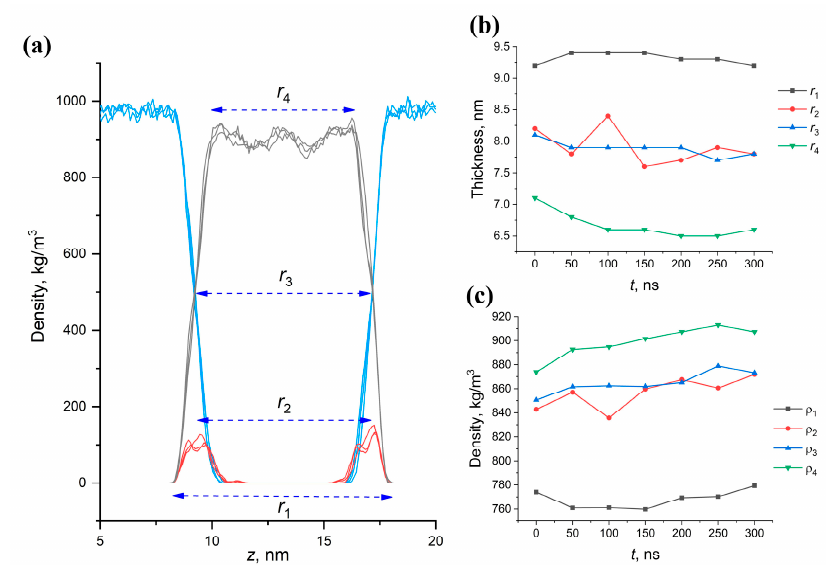
Figure 8. ( a ) Different definitions of membrane boundaries for the thickness and density evalua- tions. ( b , c ) Typical changes in the membrane thickness ( b ) and density ( c ) calculated with different definitions for the AMA-eU membrane.